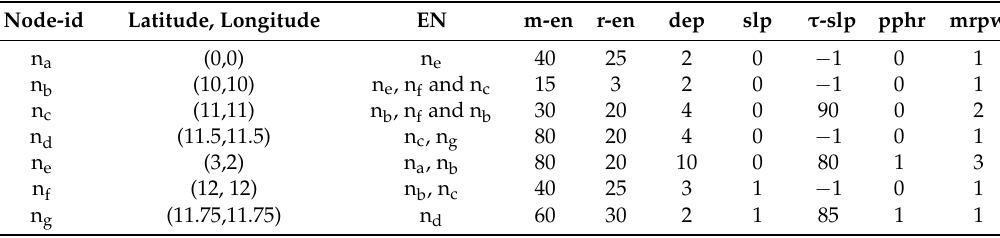
Table 3. Node identifiers and